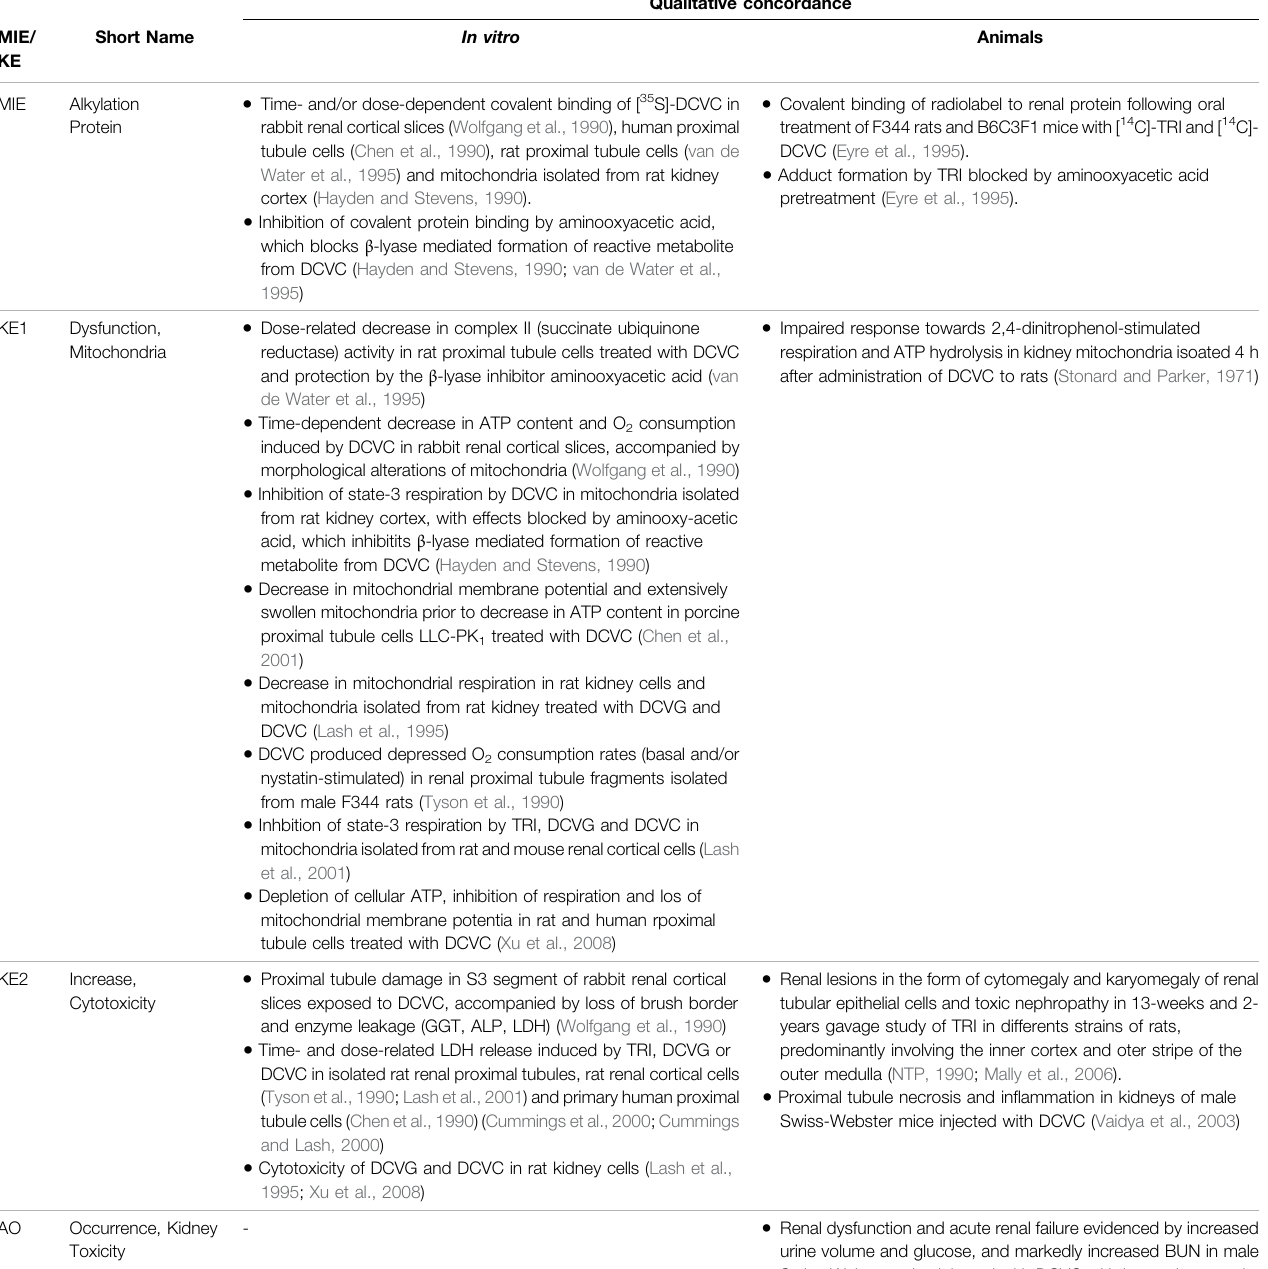
TABLE 7A | Evidence from in vitro and in vivo studies on trichloroethylene (TRI) and its metabolites S -(1,2-dichlorovinyl)-glutathione (DCVG) and S -(1,2-dichlorovinyl)- cysteine (DCVC) supporting the key events and qualitative concordance of KEs within this AOP (n/a = no data